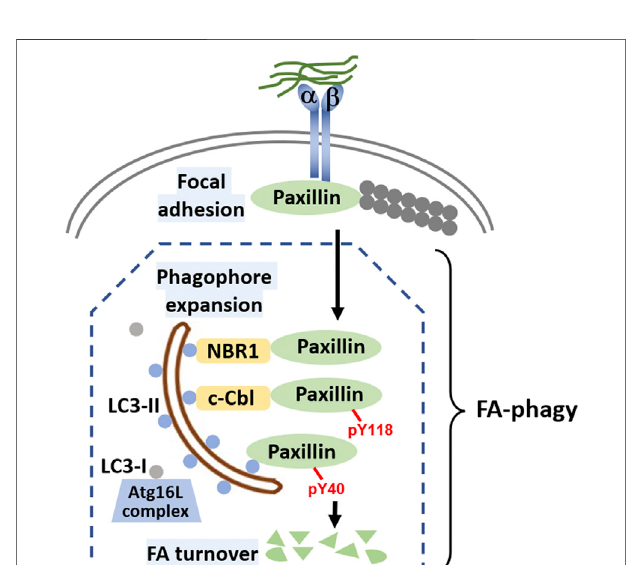
FIGURE 1 | Molecular mechanisms of FA-phagy. Focal adhesions (FAs) are simpli fi ed as protein complexes containing integrin a and ß that bind to both the extracellular matrix and intracellular paxillin protein. Filamentous actin (F-actin) comprising actin monomers are in grey and are attached to paxillin. Different cargo receptors such as NBR1 or c-Cbl, on one hand directly interact with LC3 (round blue dots associated on both sides of autophagosome), and on the other, recognize cargos such as paxillin, facilitating FA-phagy. Alternatively, paxillin can be phosphorylated at tyrosine 40 in an SRC-selective manner, which increases the binding af fi nity to LC3. In the cells, LC3 mainly has two forms, LC3-I and LC3-II. With the help of Atg16L complex, LC3-I is transformed to LC3-II by a lipidation process. Lipidated LC3-II is able to insert into both sides of the phagophore membrane, a well-established mechanism for autophagosome around the cargo. LC3-II on the inner side of the autophagosome will be degraded by lysosomal enzymes after enclosed autophagosome fuse with lysosome for cargo degradation.